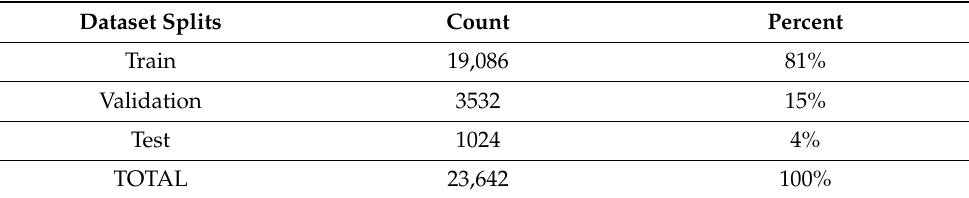
Table 1. Dataset splits used for model development. Test set from tile +14, − 40 (Figure 1). Dataset Splits Count Percent Train 19,086 81% Validation 3532 15% Test 1024 4% TOTAL 23,642